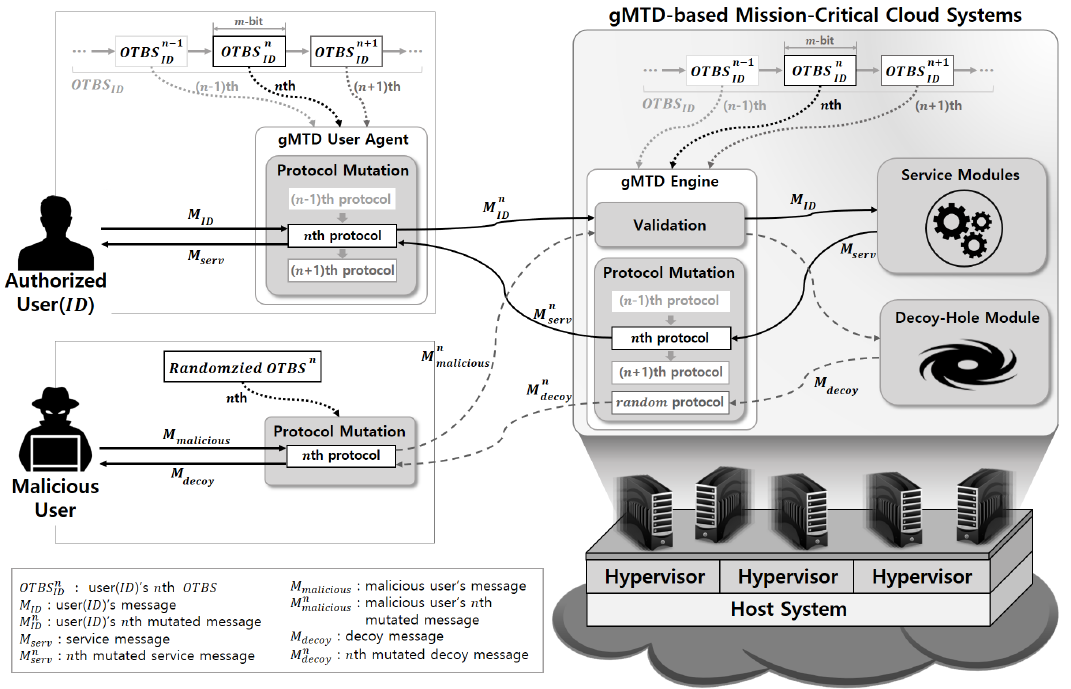
Figure 1. Overall architecture of Ghost moving target defense ( gMTD ) and an example of a mission-critical cloud system enhanced with gMTD